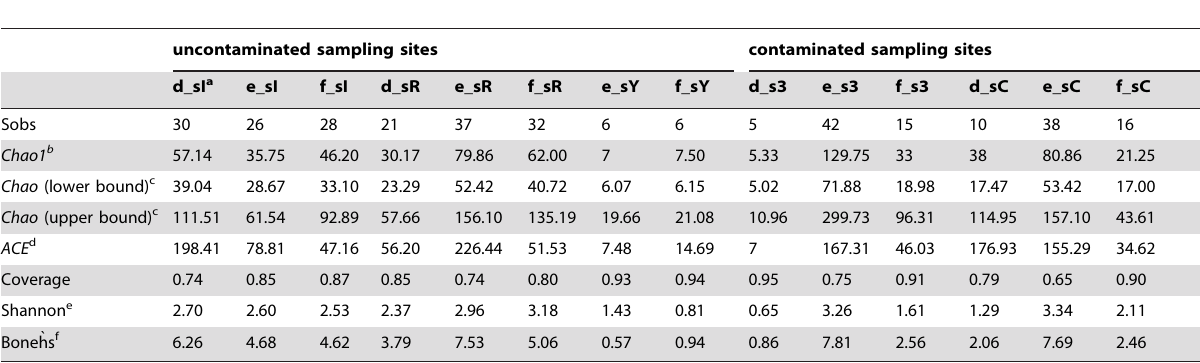
Table 4. Data obtained from the statistical analyses of clone